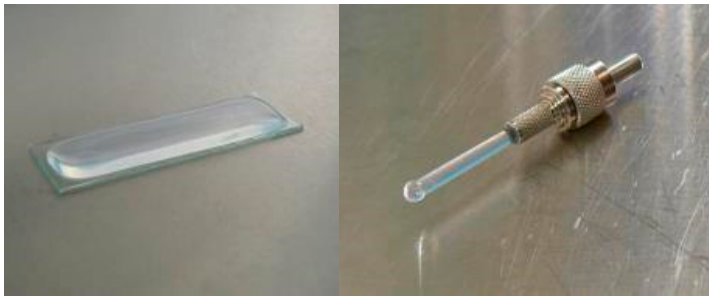
Figure 1. The bacteria are immobilized on the tip of an optical fiber and a microscope slide .